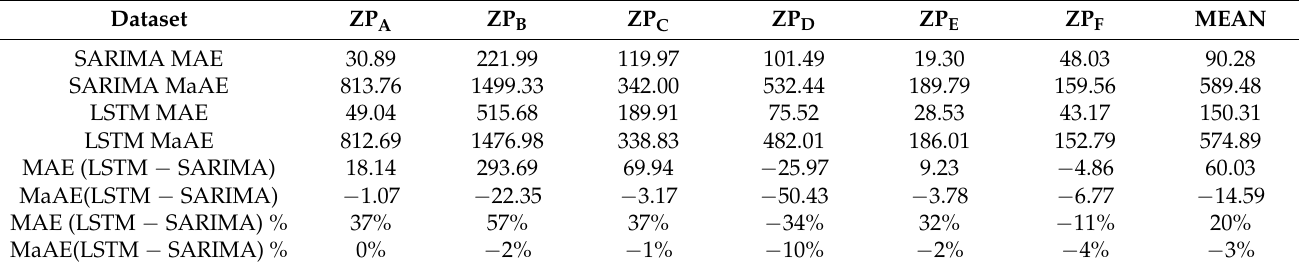
Table 7. Comparison of algorithm simulation results for datasets ZP A , . . . , ZP F .